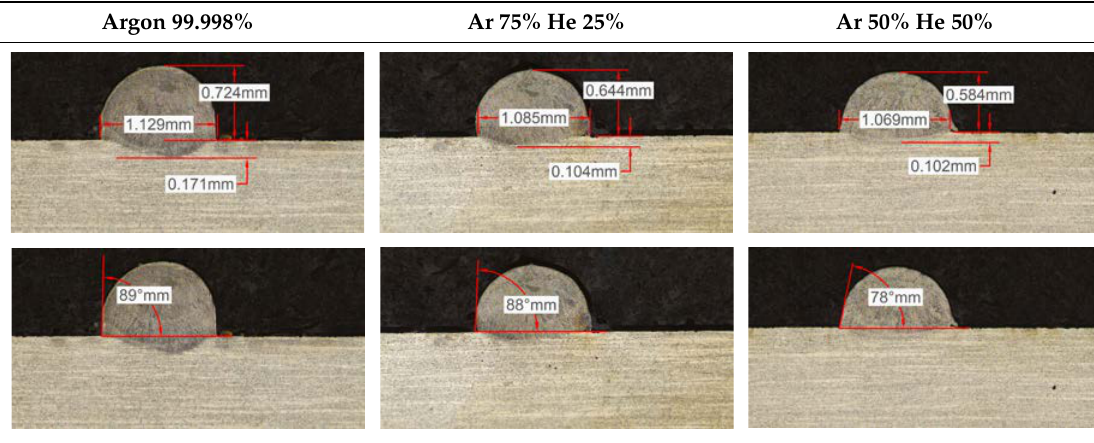
Table 5. Measurements for different gases at 400 W.